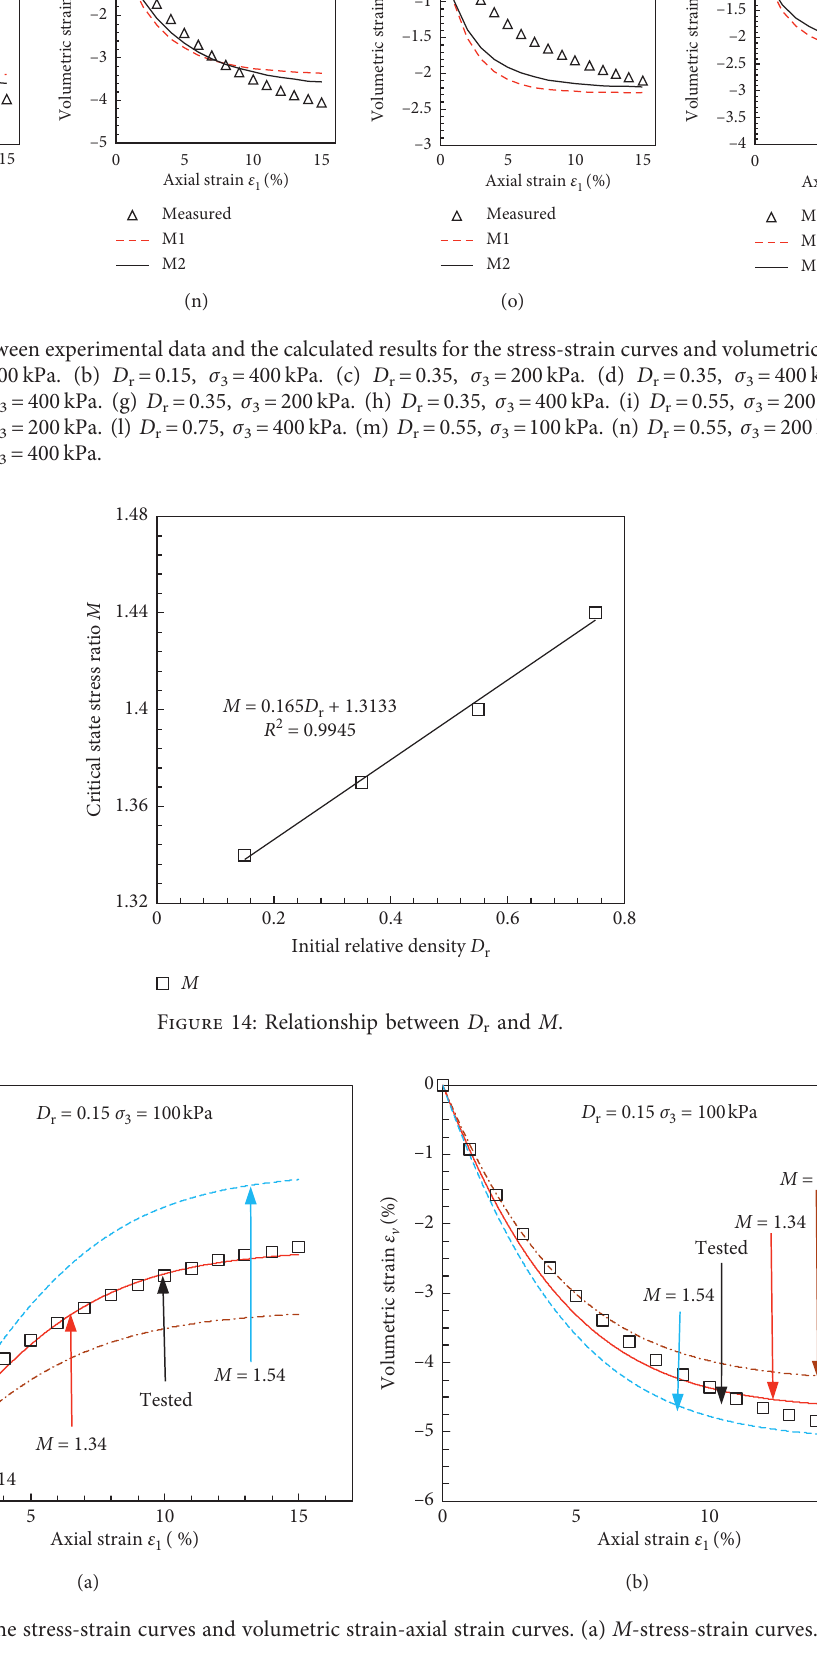
Figure 15: Effects of M on the stress-strain curves and volumetric strain-axial strain curves. (a) M -stress-strain curves. (b) M -volumetric strain-axial strain curves.